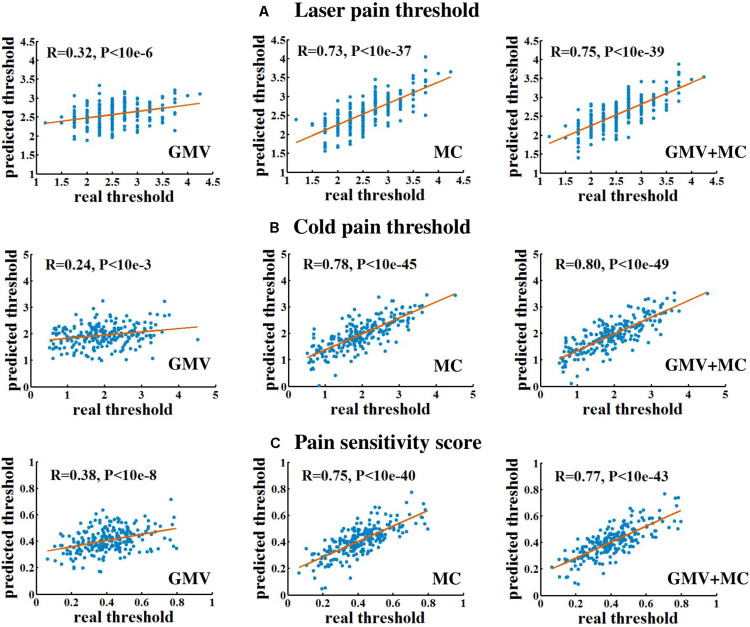
The linear correlation between predicted and real pain thresholds. (A) Prediction of laser pain threshold. (B) Prediction of cold pain threshold. (C) Prediction of pain sensitivity score. Each blue dot denotes one participant. Red lines are linear fitting lines.